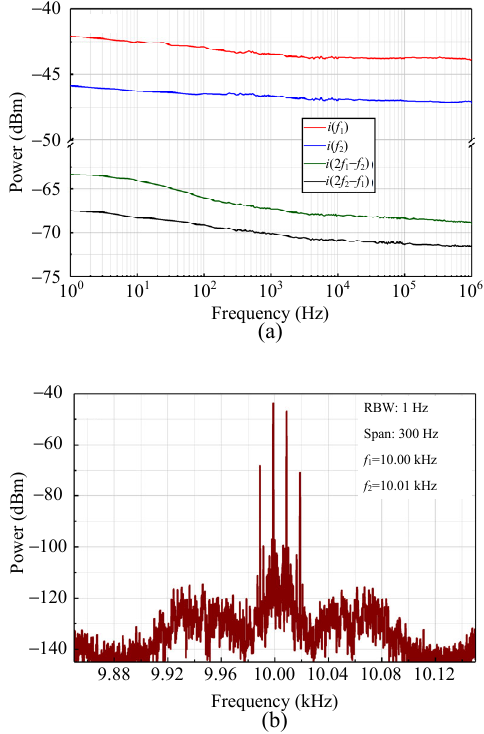
Fig. 2 Measured electrical power and spectra: (a) electrical power of the electrical signals after photodetection at f 1 , f 2 , 2 f 1 – f 2 , and 2 f 2 – f 1 and (b) electrical spectrum in the case of f 1 = 10 kHz and f 2 = 10.01 kHz.